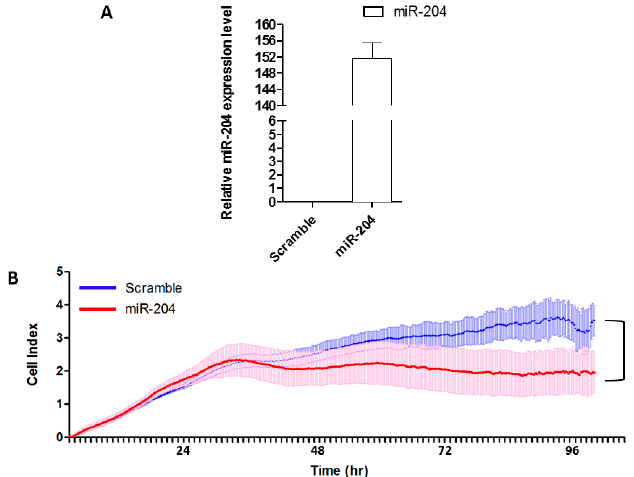
Figure 4. MiR-204 inhibits the proliferation of gastric cancer cells. ( A ) Over-expression of miR-204 was determined by real time qRT-PCR in AGS cells, ( B ) Cell proliferation was determined in the AGS gastric cancer cell line transfected with miR-204 mimic or scrambled control.